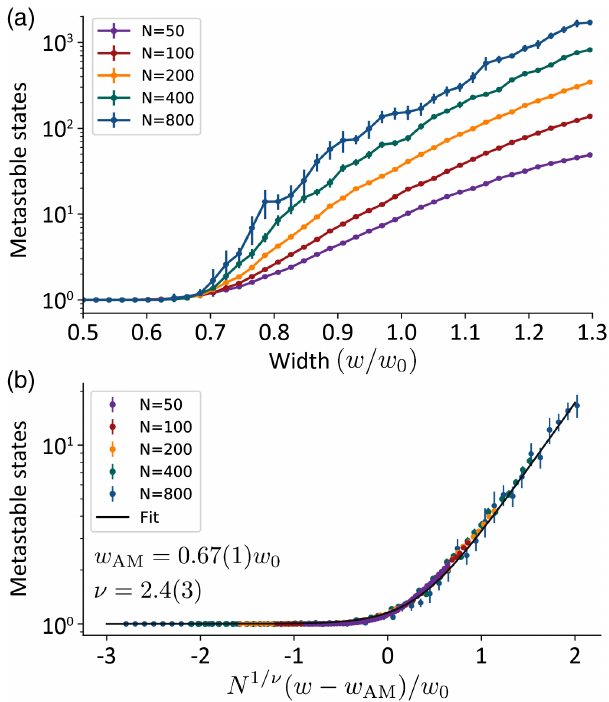
FIG. 5. (a) Number of metastable states versus distribution width for various system sizes N , as indicated. The average number of metastable states increases with N above the ferromagnetic-to- 0 . 67 ð 1 Þ w associative memory transition at w 0 . (b) Scaling AM ¼ collapse of the above in the region 0 . 5 w 0 < w < 0 . 8 w 0 , with =w 0 , denser sampling. The x axis is rescaled as N 1 = ν ð w − w AM Þ while the y axis is unchanged. The parameters ν and w are AM determined by fitting the collapsed data to an exponential form ffiffiffiffiffiffiffiffiffiffiffiffiffiffiffiffiffiffi p 1 þ Ae Bx =w 0 . The uncertainties are , where x ¼ N 1 = ν ð w − w AM Þ one standard